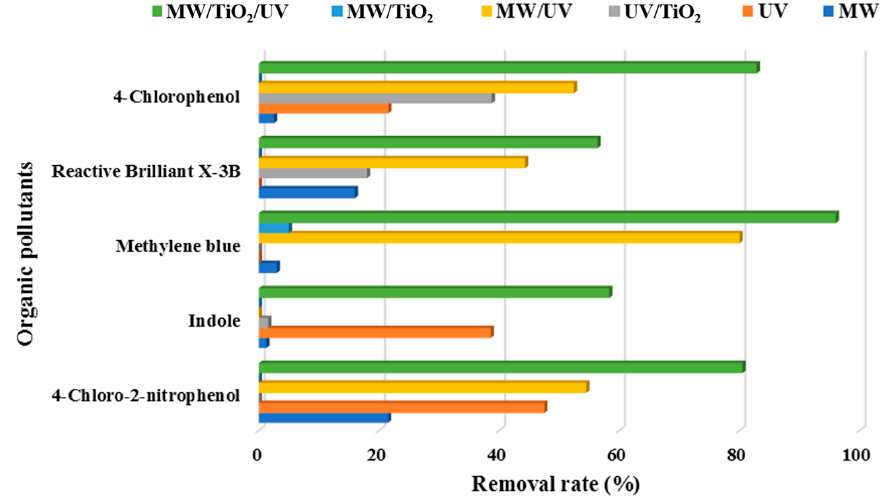
Figure 3. Degradation of organic pollutants efficiency under different process conditions.